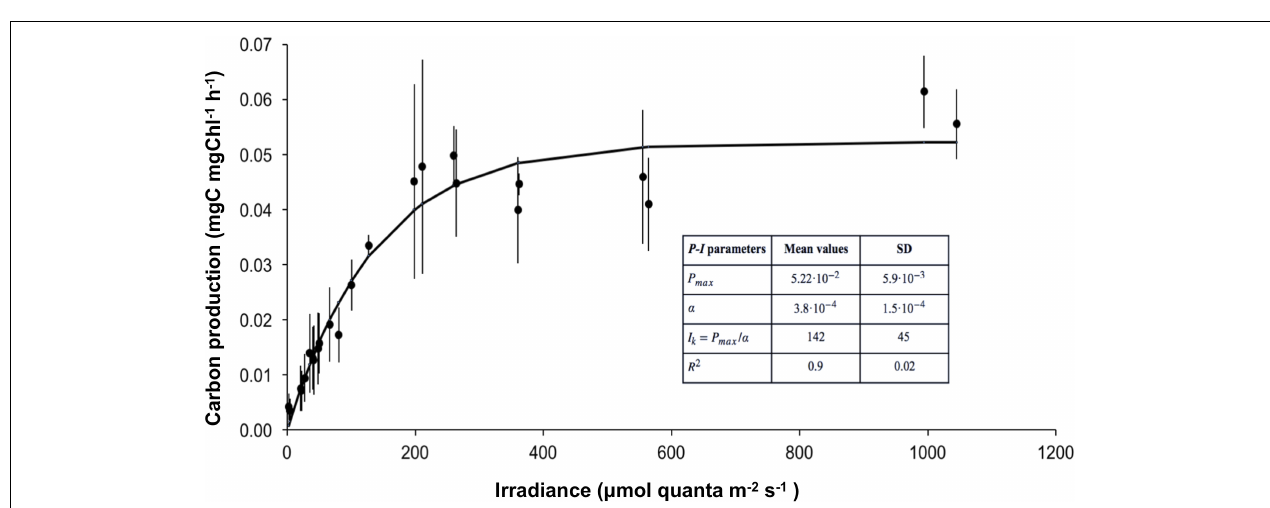
FIGURE 7 | Photosynthesis vs. irradiance (P-I) curve of cultured Symbiodiniaceae isolated from C. tuberculata . The curve was obtained by fitting the data to the model of Webb et al. (1974). Error bars show standard deviation.